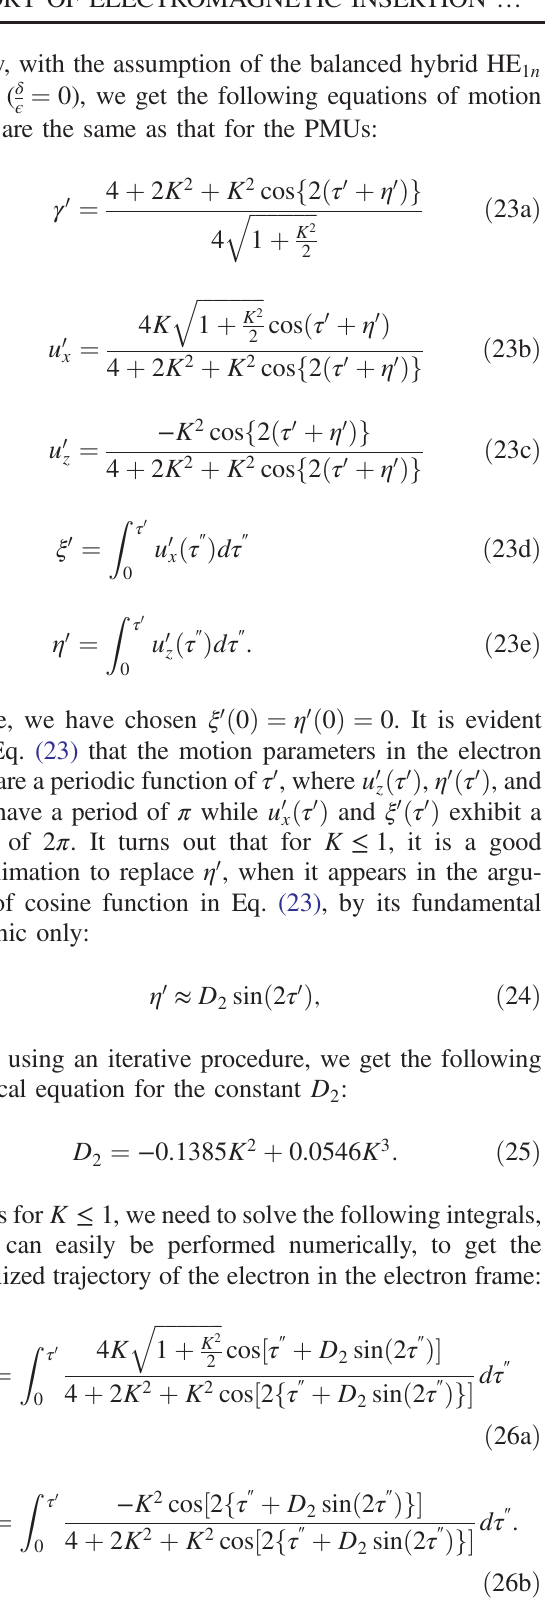
FIG. 1. Normalized orbit of the electron in the electron inertial frame for two different values of K . At τ 0 ¼ 0 ; 2 π ; 4 π ; … the electron crosses the origin to enter the second quadrant from the fourth. At τ 0 ¼ π ; 3 π ; 5 π ; … the electron crosses the origin to enter the third quadrant from the